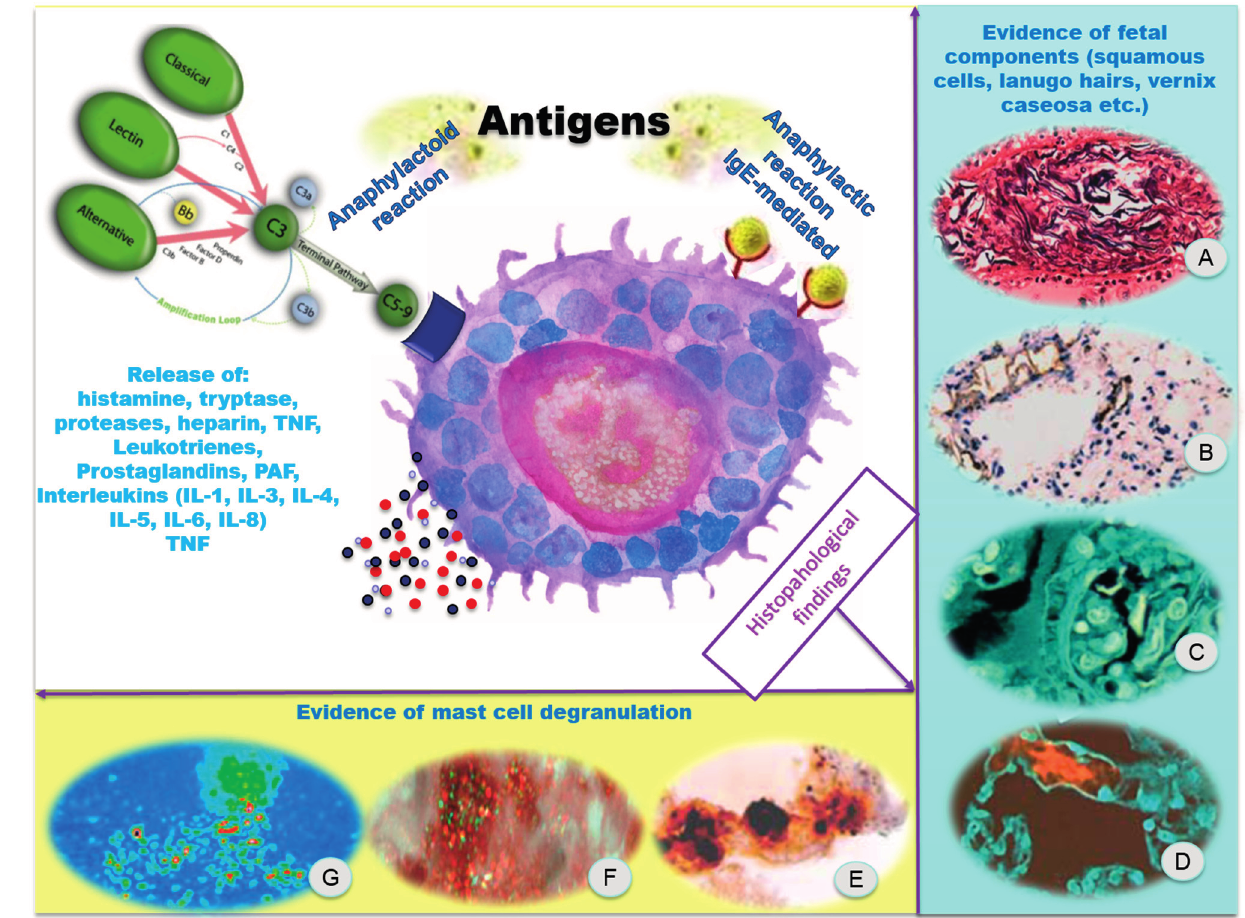
Figure 2. The immuno-inflammatory pathogenesis and the target organs. ( A ) Evidence of fetal squamous cells, lanugo hairs, vernix caseosa, in the pulmonary artery vasculature (Hematoxylin-eosin staining, 200×); ( B ) AE1/AE3 cytokeratin stains on the lungs showed intense intravascular positivity of fetal squamous cells; ( C ) Lanugo hairs and nuclei of fetal squamous cells are clearly visible (confocal laser scanning microscope); ( D ) Mucin fluoresced (in red) in the pulmonary capillary septa (confocal laser scanning microscope); ( E ) Pulmonary capillary septa: evidence of degranulating mast cells with tryptase-positive material outside the cells (Ab anti-tryptase); ( F , G ) Degranulating mast cells with tryptase-positive material outside the cells (confocal laser scanning microscope).